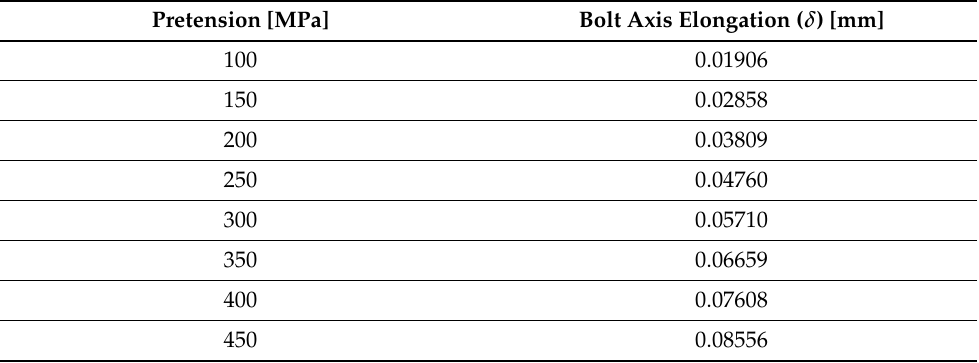
Table 1. Bolt axis elongation ( δ ) computed using Equation (9), for different values of